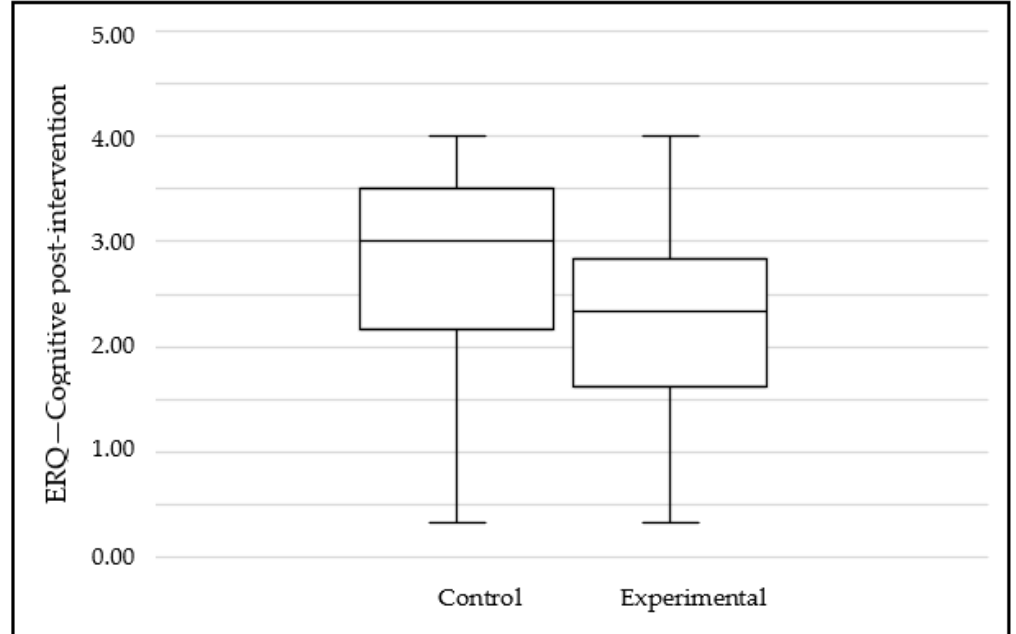
Figure 2. Mean scores for ERQ—Cognitive subscale at post-intervention by groups.